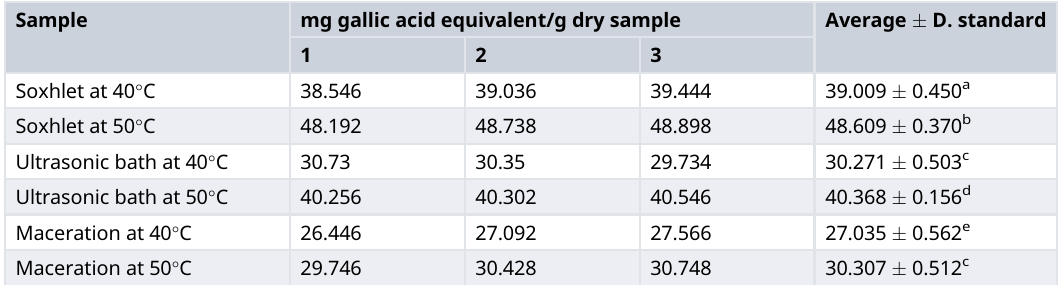
Table 5. Total phenolic content corresponding to the equivalent of gallic acid.